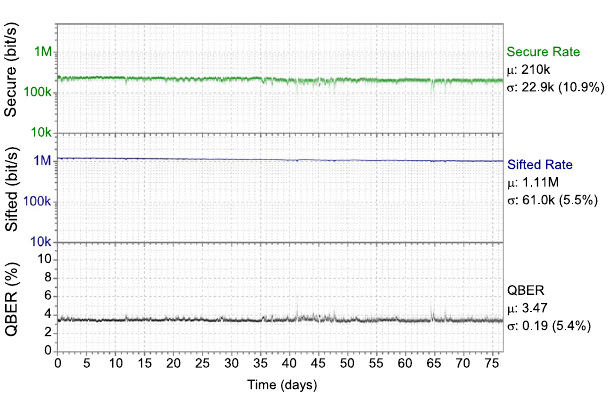
Figure 5. Field trial performance of the QKD system installed in a 45 km telecom fibre link over a 77 day period, with collective attack security. From upper to lower the secure key rate, sifted key rate and QBER are shown along with their mean value ( μ ) and standard deviation ( σ